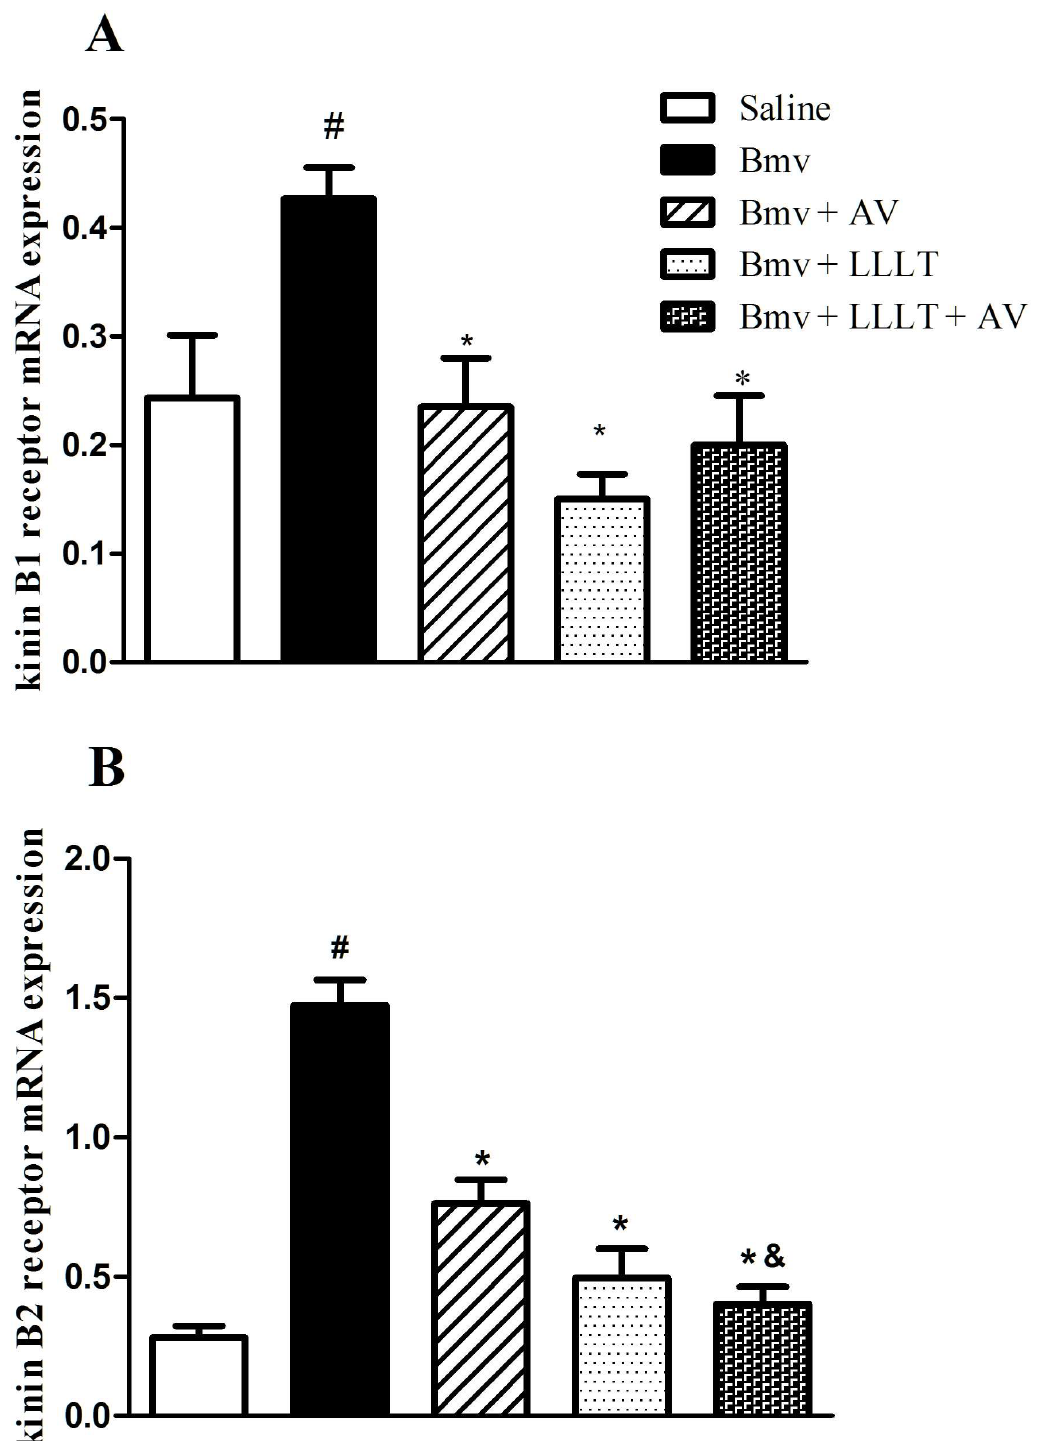
Fig 4. Effect of LLLT on kinin receptor mRNA expression. mRNA levels of B1 (A) or B2 (B) kinin receptors were evaluatedby RT-PCR on footpad samples of the mice injected intraplantarwith saline or Bmv (1 μ g) and treated or not with LLLT 685 nm at or antivenom(AV) or a combination of LLLT and AV. Samples were collected 6 h after saline or Bmv injection.Experiments were performed in triplicates. Data are expressed as means ± SEM of 5 animals from each group. Statistically significant differences vs. saline( # p < 0.05) or vs. Bmv ( * p < 0.05) or vs Bmv + AV ( & p < 0.05) are indicated.